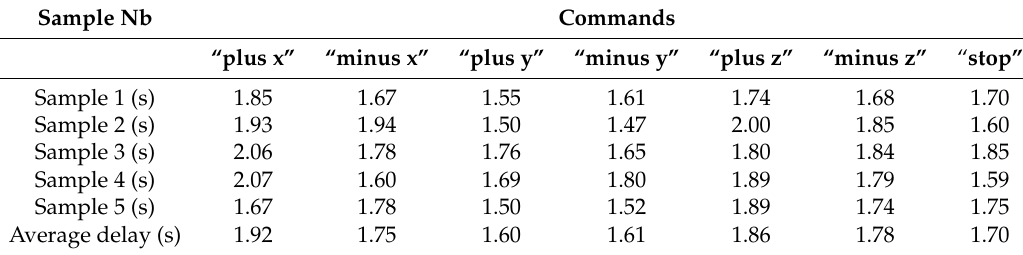
Figure 8. Measurement of the delay of the robot’s reaction to the voice command: real station.